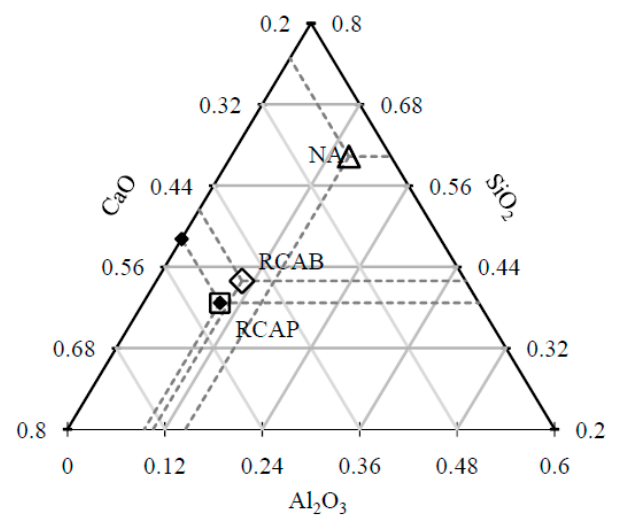
Figure 9. Positions of the NA, RCAB, and RCAP on the CaO–SiO 2 –Al 2 O 3 ternary diagram.